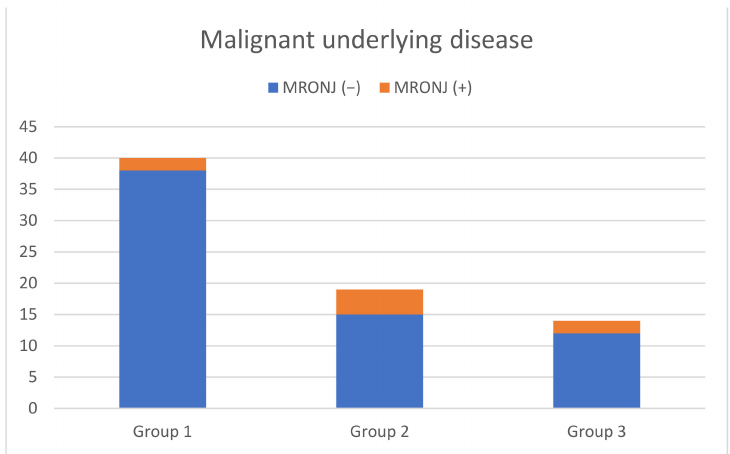
Figure 2. Occurrence of MRONJ among patients with malignant underlying disease depending on the surgical intervention. ( p = 0.165).